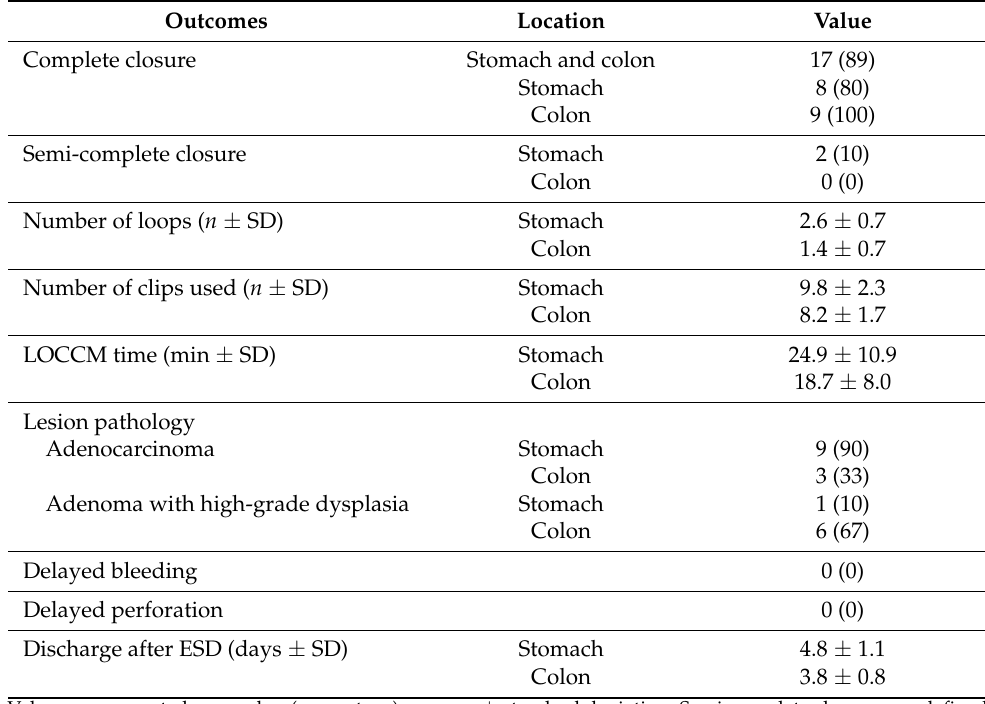
Table 2. Treatment outcomes of the loop and open–close clip closure method ( n =